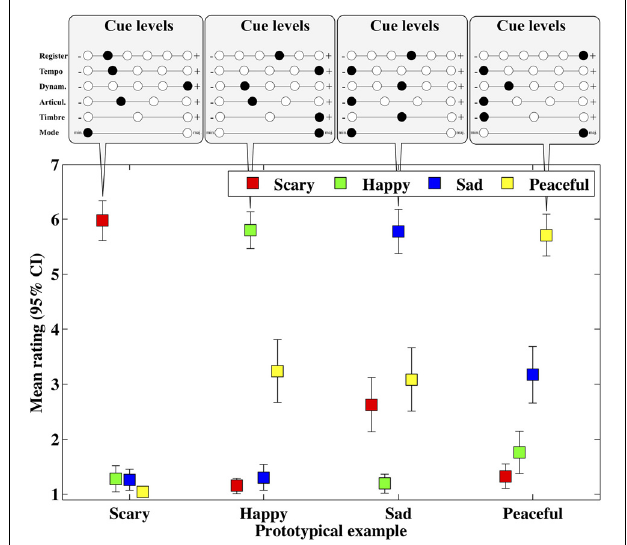
FIGURE 1 | Means and 95% confidence intervals of four emotion ratings for four prototype examples that received the highest mean on each